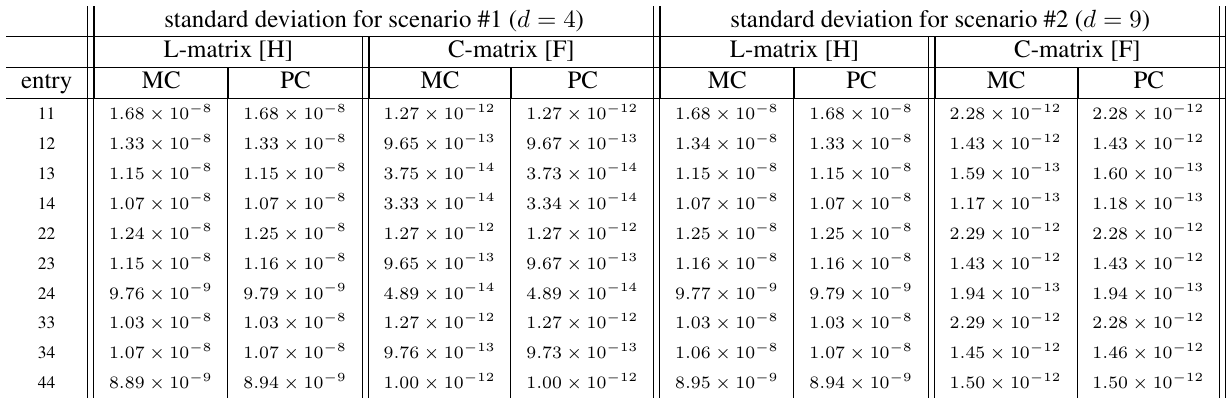
Table 1: Standard deviations of the p.u.l. inductance and capacitance matrix entries for the ribbon cable of Fig. 2.